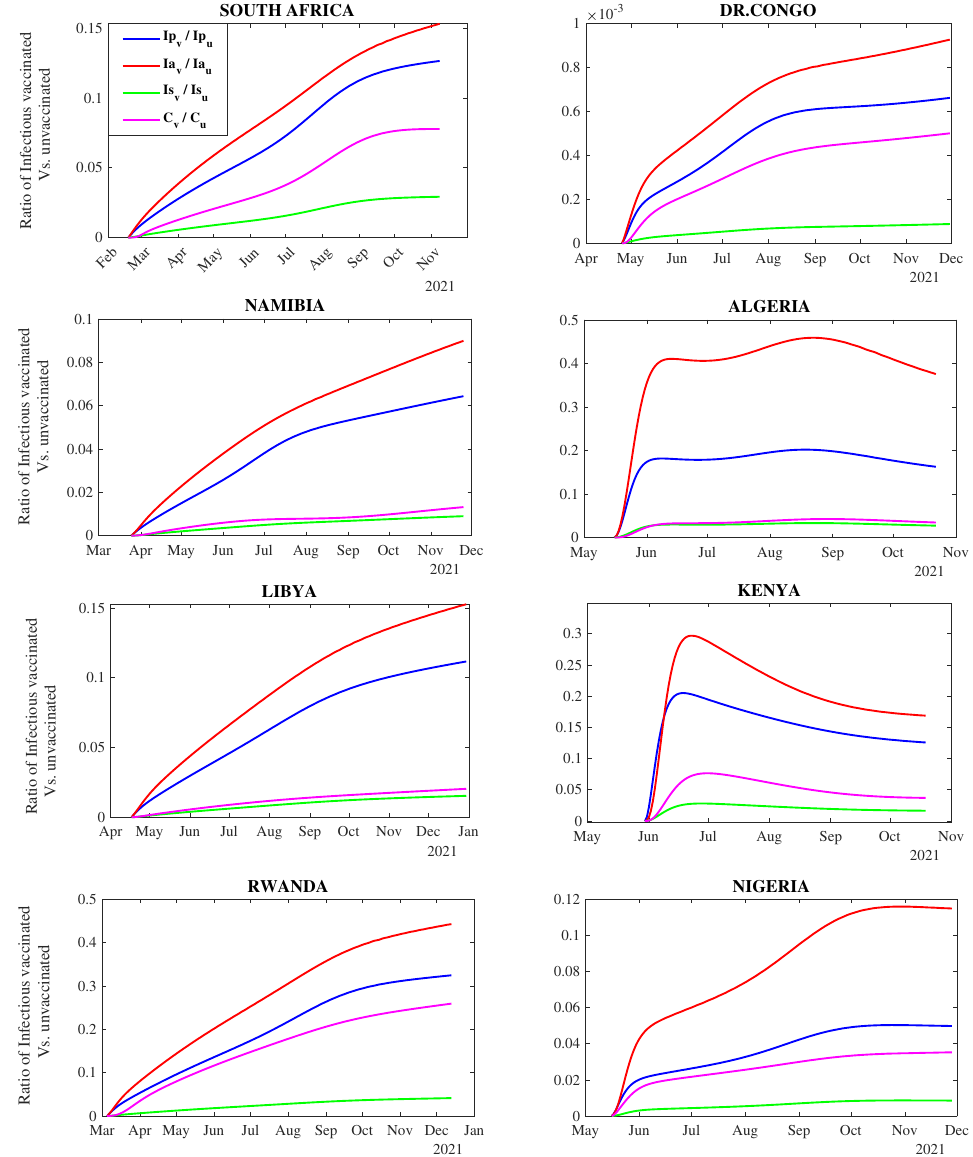
Figure 2. Evolution trend of each infectious compartment for vaccinated and unvaccinated individ- uals over time in each country. The first line (purple) in the legend depicts the ratio of the number of confirmed infectious vaccinated individuals to confirmed infectious unvaccinated individuals, the second line (green) depicts the ratio of the number of symptomatic infectious vaccinated individ- uals to the symptomatic infectious unvaccinated, the third line (red) depicts the ratio of the number of asymptomatic infectious vaccinated individuals to asymptomatic infectious unvaccinated, and the last line (blue) depicts the ratio of the number of pre-symptomatic infectious vaccinated individuals to pre-symptomatic infectious